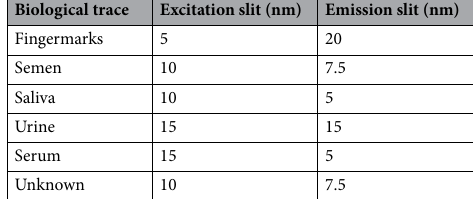
Table 3. Spectral band pass width of excitation and emission